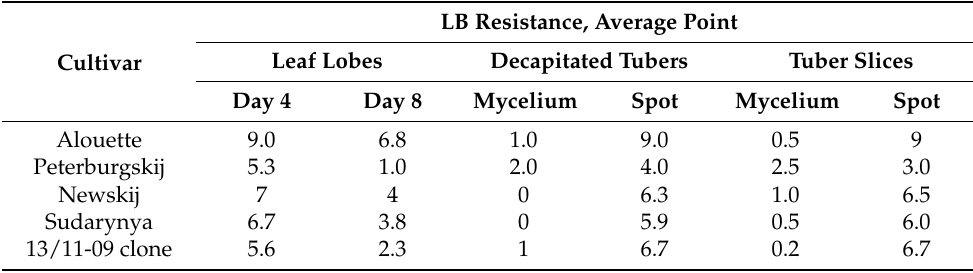
Table 2. Leaf and tuber LB resistance of reference cultivars and parents in the Sudarynya × 13/11-09 combination in laboratory